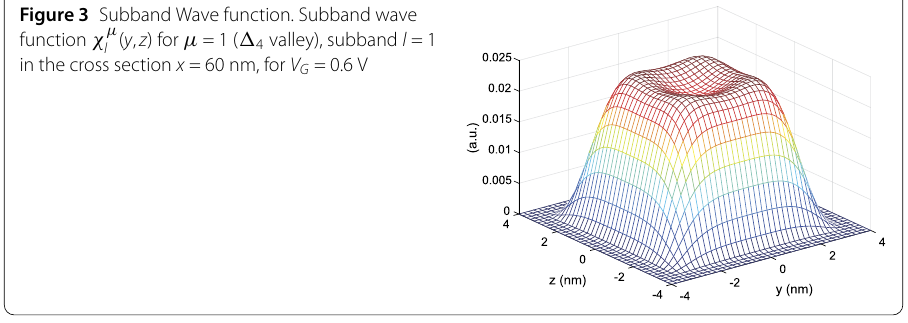
Figure 4 Subband Wave function. Subband wave function χ μ